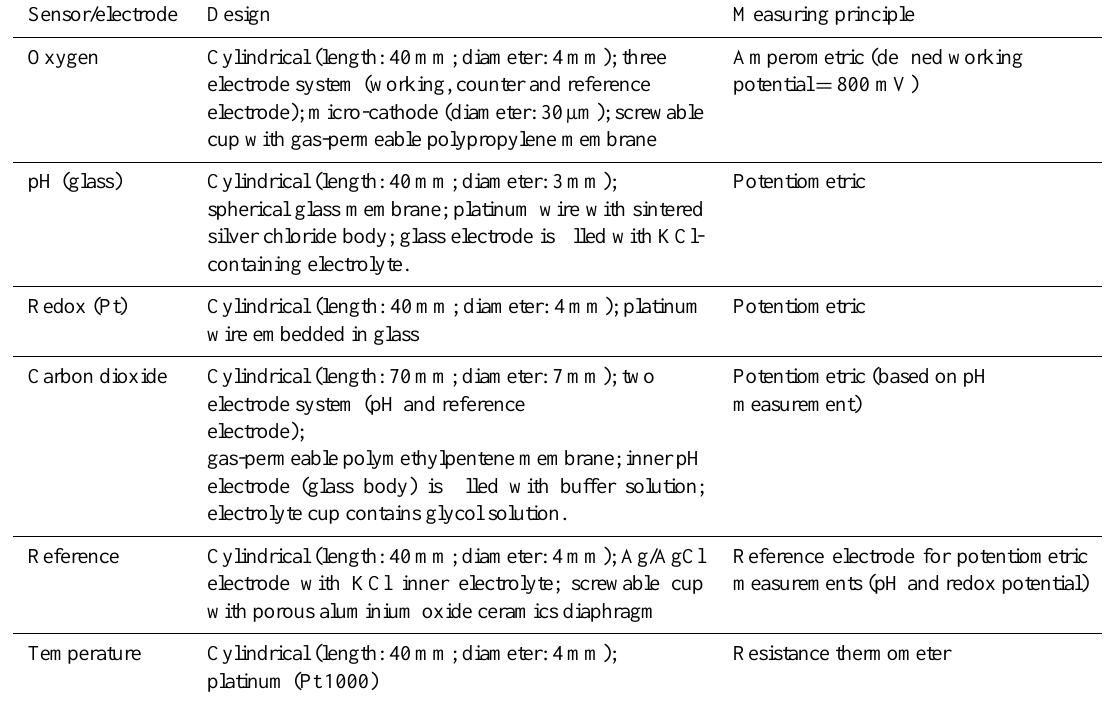
Table 2. Overview of the miniaturised sensors installed in the multi-sensor